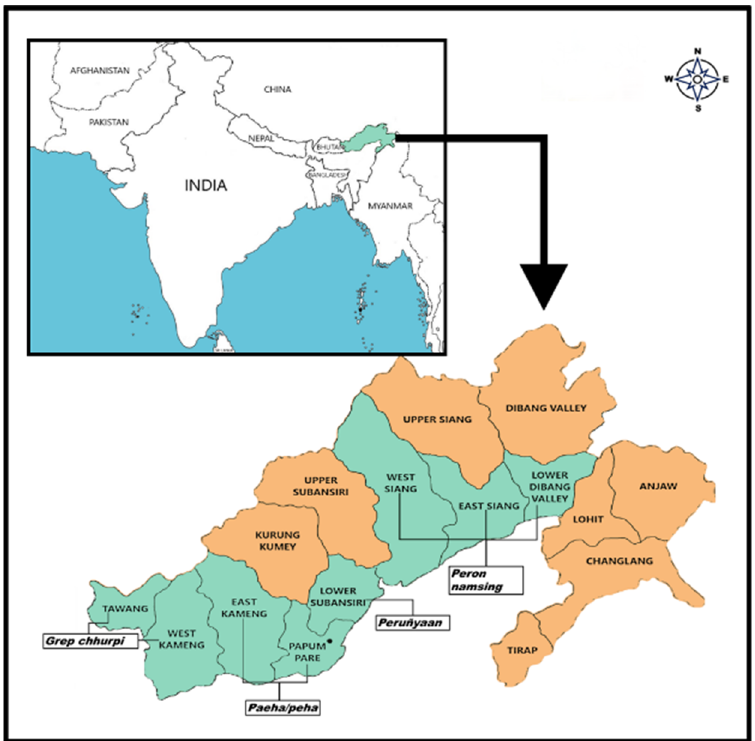
Figure 1. Sample collection sites in Arunachal Pradesh, India.